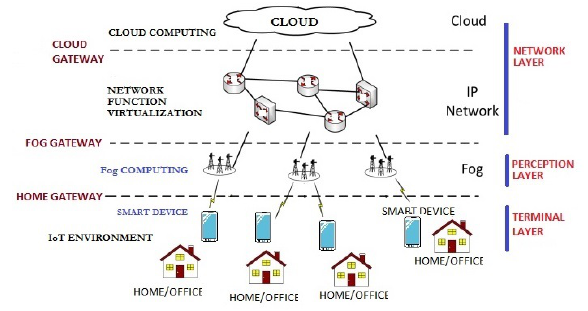
Fig. 2. Multi-Layer Cloud-Fog-IoT